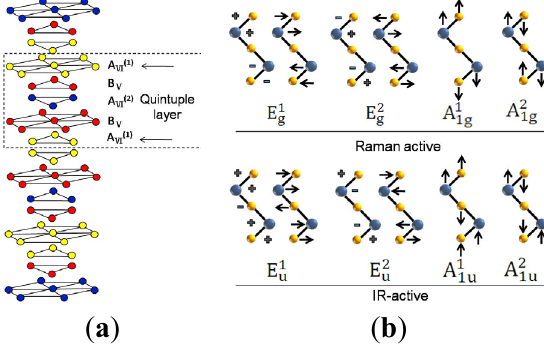
Figure 3. ( a ) Schematic diagram of Bi 2 Te x Se 3 − x crystal structure. ( b ) Schematic diagram of Raman active and Infrared-active (IR-active) vibration modes.